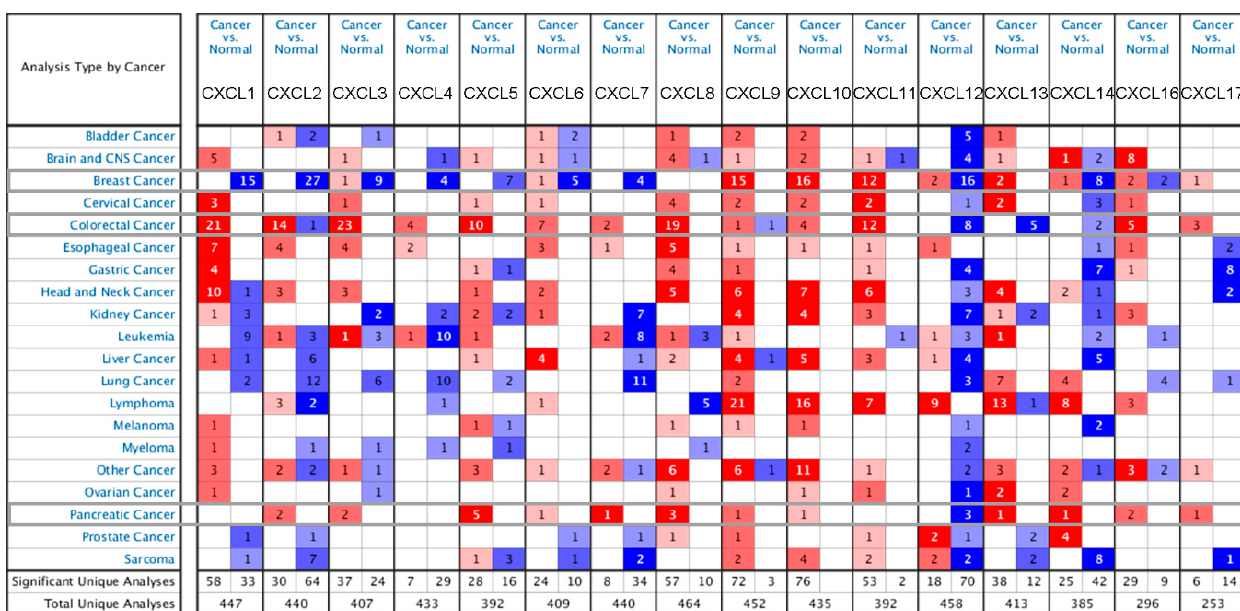
Figure 2. Transcriptional expression of CXCs in 20 different kinds of cancer diseases (ONCOMINE database). Difference in transcriptional expression was compared using Students’ t -test. Cut-off of p value and fold change were as follows: p value: 0.05; fold change: 2.0; gene rank: 10%; data type: mRNA.